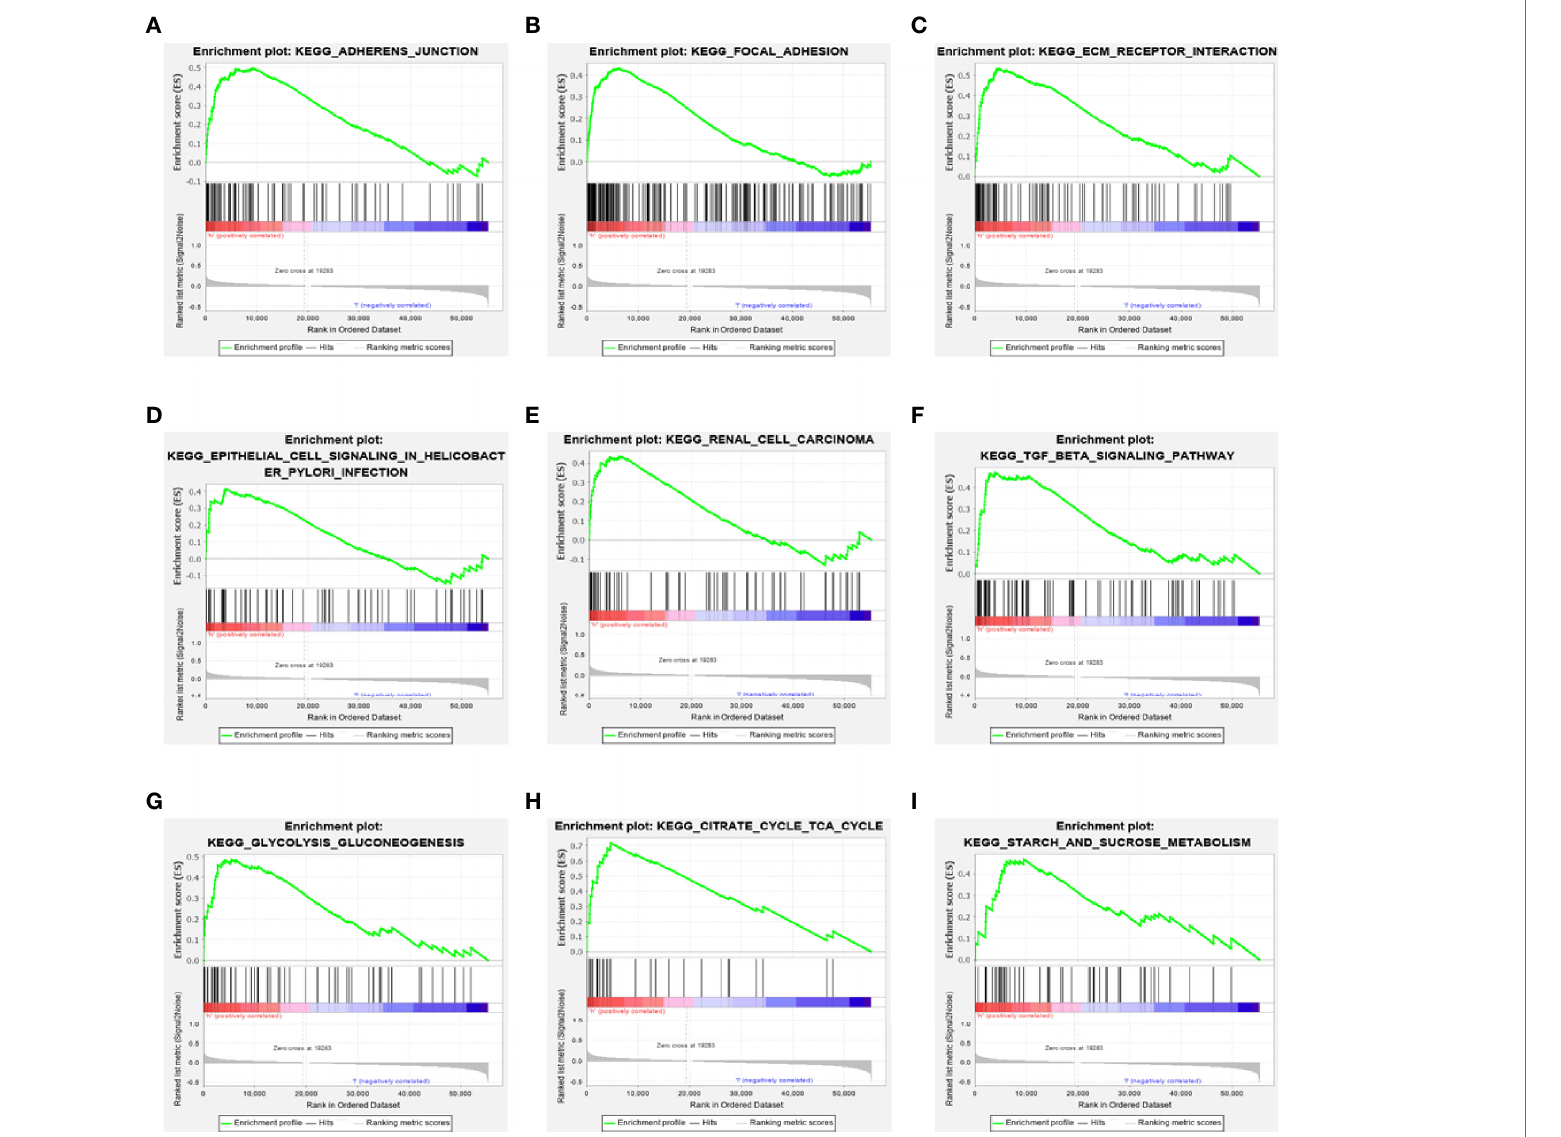
FIGURE 7 | Gene set enrichment analysis. (A – F) GSEA suggested notably enrichment of cancer-related pathways in the high-risk group based on training set. (G – I) GSEA suggested signi fi cant autophagy-related enrichment based on training